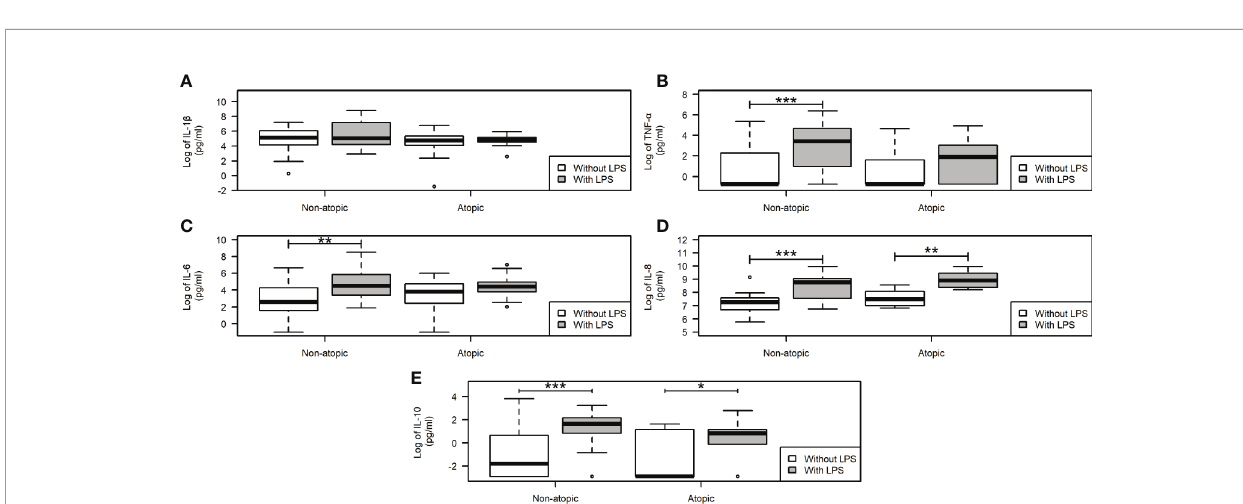
FIGURE 2 | Cytokine production by neutrophils from non-atopic and atopic runners. Production of proin fl ammatory IL-1 b (A) , TNF- a (B) , IL-6 (C) , IL-8 (D) , and the anti-in fl ammatory IL-10 (E) cytokines. After incubation, the supernatant was removed, the cytokine secretion was measured by CBA upon stimulation with 5 m g/mL LPS for 18 h, and data were acquired by fl ow cytometry using the BD Accuri software and analyzed using the FCAP software (Becton Dickinson, San Juan, CA, USA). The results are presented as medians (middle lines). The 25 – 75% con fi dence intervals (closed boxes) and the 5 – 95% con fi dence intervals (lower and upper lines, respectively) are indicated. *p < 0.05 when comparing neutrophils in the absence of LPS stimulus. *p < 0.05 when comparing neutrophils in the absence of LPS stimulus. **p < 0.01 and ***p <